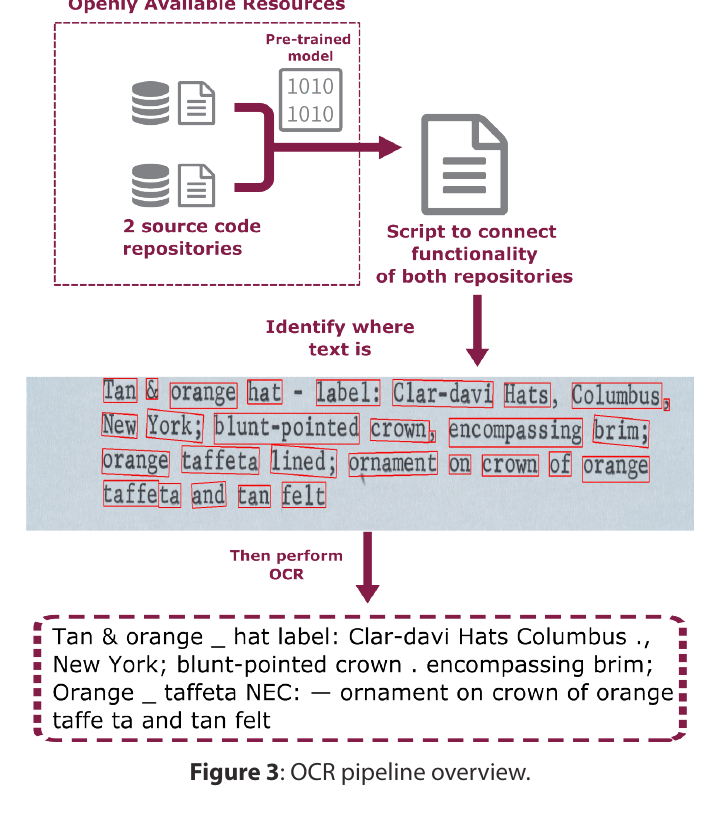
Figure 3 : OCR pipeline overview.